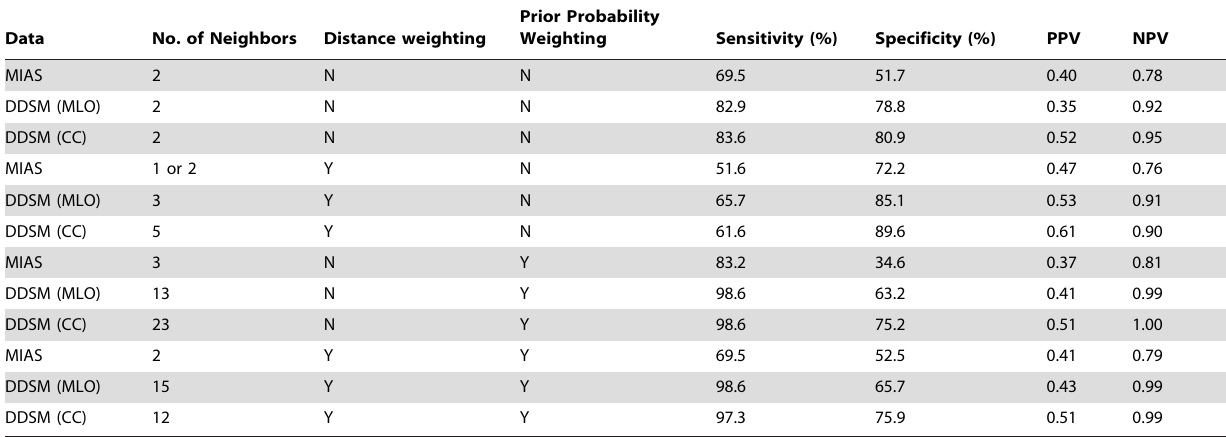
Table 1. KNN classifier performance.